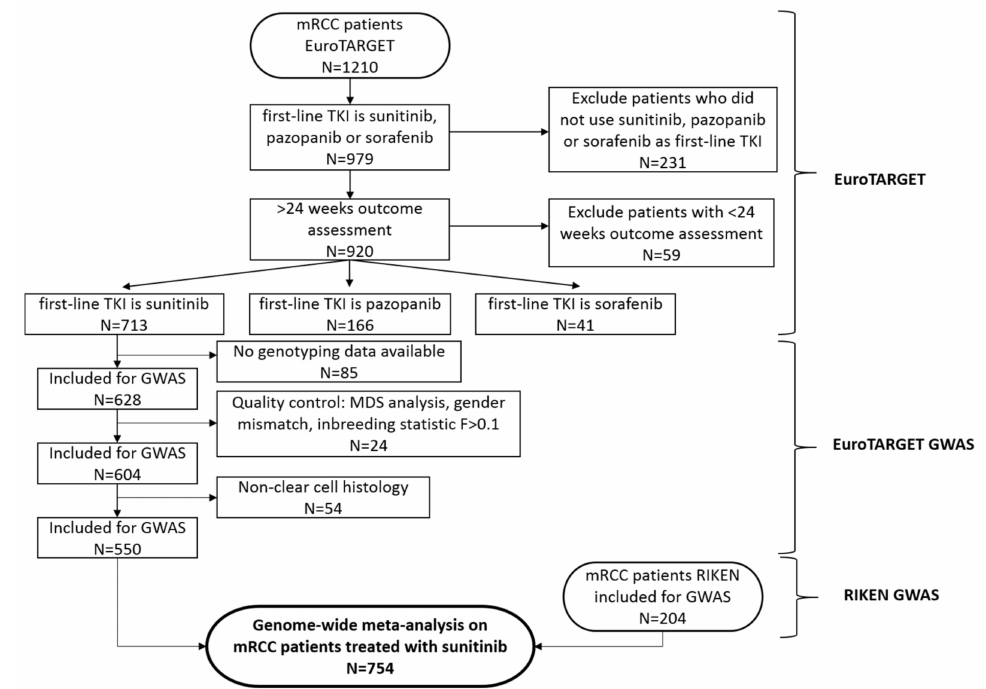
Figure 1. Flowchart on patient inclusion EuroTARGET and RIKEN. N indicates the number of patients. In total, 1210 mRCC patients were included in EuroTARGET, of which 748 were collected prospectively and 462 were available as historical (retrospective) series at the start of EuroTAR- GET [21]. Of the 1210 patients, we selected the 979 patients (81%) who received sunitinib, sorafenib, or pazopanib as first TKI (remainder of patients did for example have no treatment or were treated with an mTOR inhibitor or other TKI). We did not exclude patients who used cytokine therapy before the TKI. To allow for informative analyses, we only focused on the subset of 920 patients for whom outcome could be assessed for at least 6 months (24 weeks). Patients with missing genotypes (N = 85) were excluded for GWAS purposes. 24 patients were excluded after Quality Control (QC) checks. For efficacy analyses, 54 non-clear cell patients were excluded resulting in 550 patients available for the EuroTARGET GWAS [21]. An additional 204 patients from 15 Japanese medical institutes, the RIKEN cohort, was included to test efficacy endpoints in a genome-wide meta-analysis on mRCC patients treated with